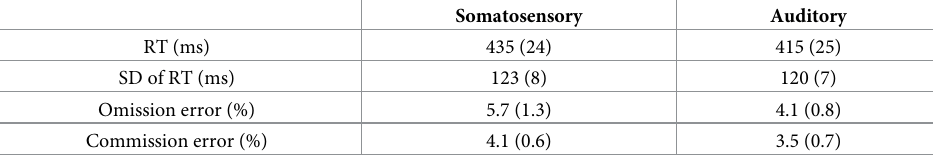
Table 1. Behavioral data during somatosensory and auditory Go/No-go paradigms with SE.